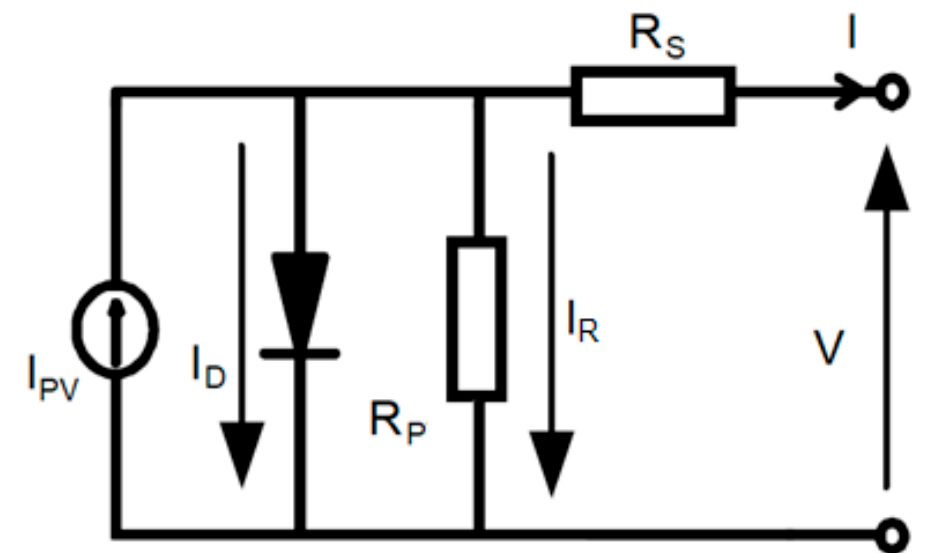
Figure 1. Electrical equivalent circuit of the photovoltaic module.